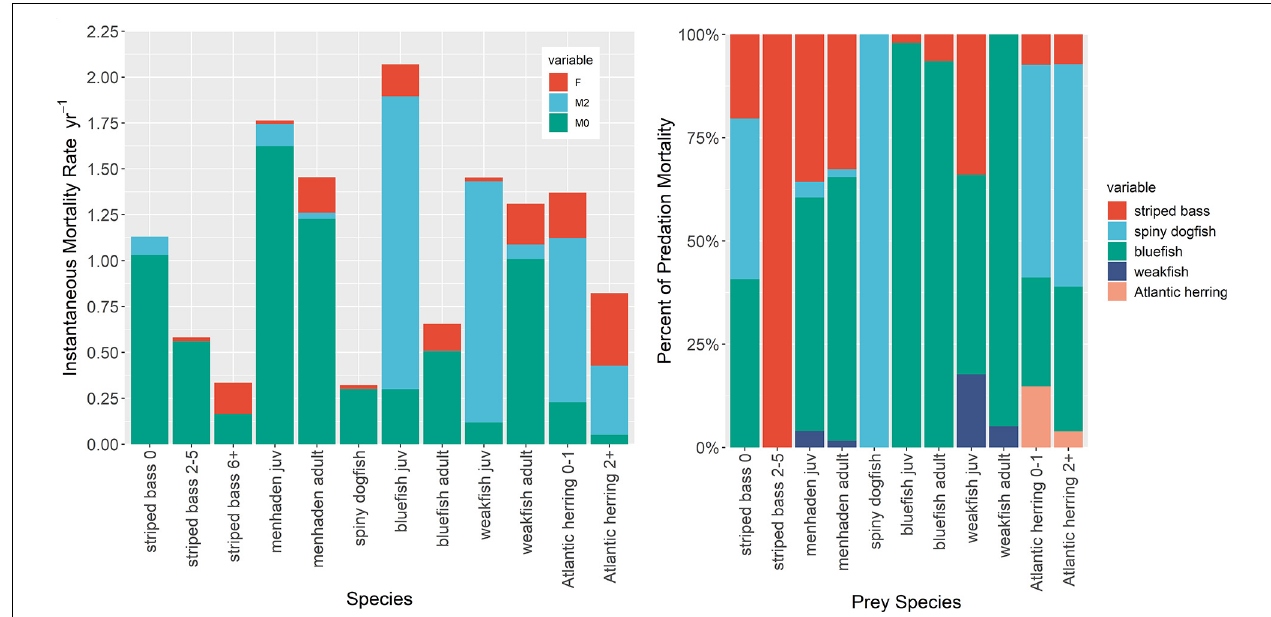
FIGURE 1 | Mortality components of species in the ERP complex from the NWACS-MICE Ecopath model describing (Left) how mortality is partitioned among fishing ( F ), predation ( M2 ), and other ‘unexplained’ mortalities ( M0 ). The predation mortality component is further partitioned into predator species, combined over age stanzas (Right)